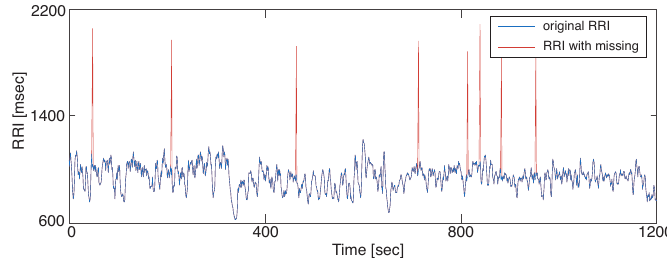
Figure 3. Example of missing RRI with α = 0.5%: some RRIs were intentionally eliminated randomly.